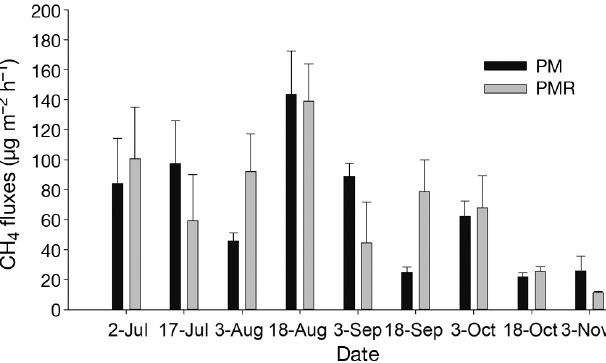
Fig. 2. Variations in methane (CH 4 ) fluxes in the PM and the PMR (defined in Table 1) during the farming